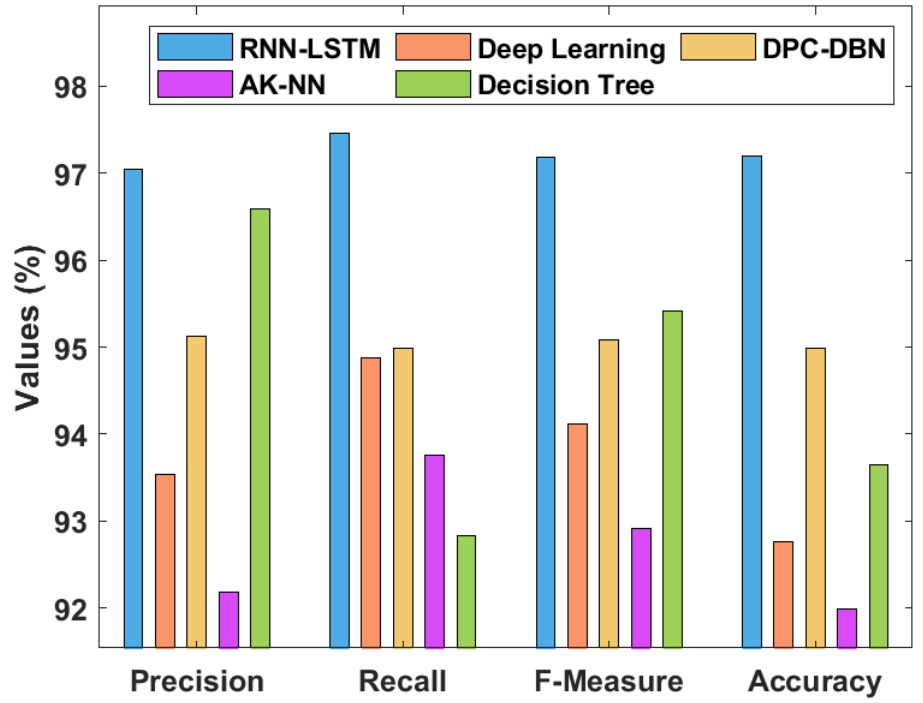
Figure 10. The Comparative results analysis of existing with RNN-LSTM model.